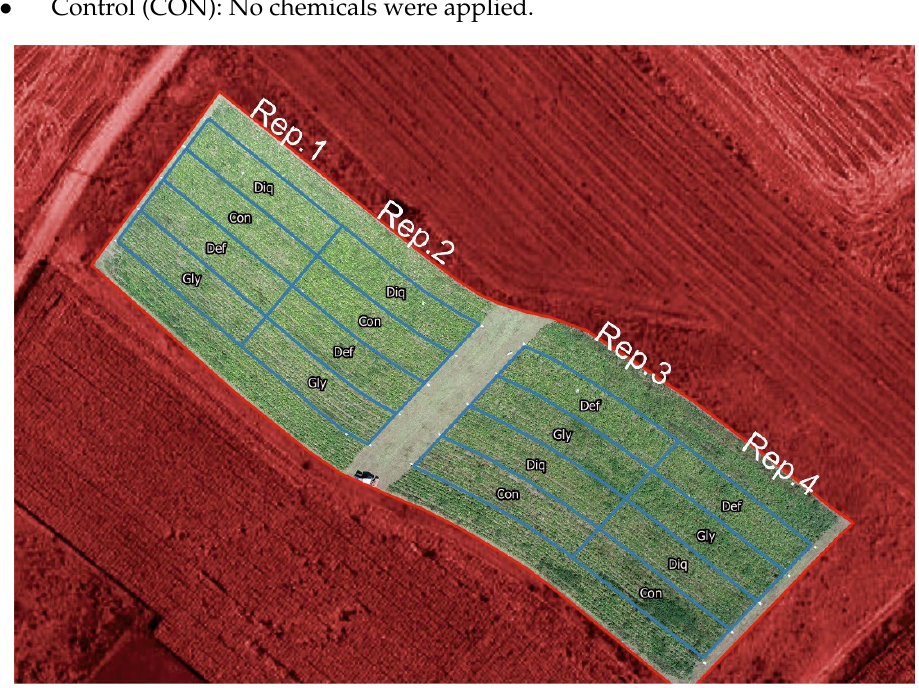
Figure 1. Aerial picture of the field trial with indication of the experimental design Gly = Glyphosate, Def = Defoliant, Diq = Diquat, Con = Control. Def = Defoliant, Diq = Diquat, Con =